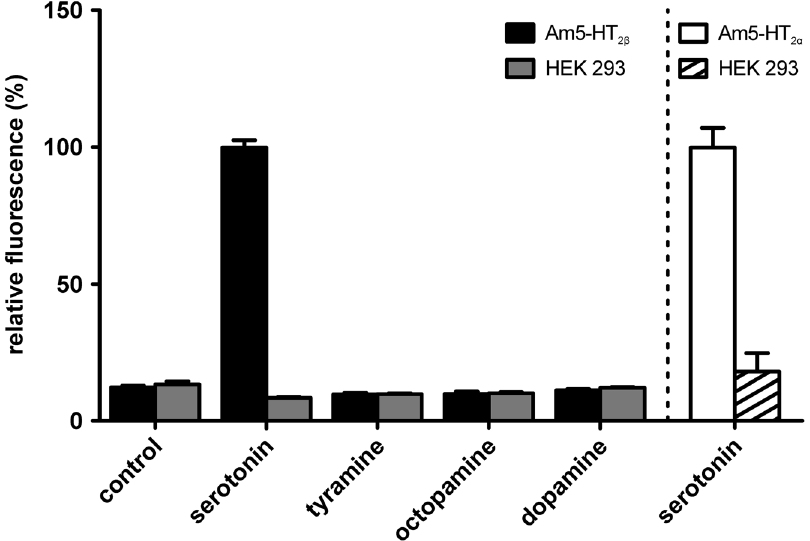
Figure 5. Biogenic amine (10 m M each) modulation of intracellular Ca 2 + concentrations in HEK 293 cells constitutively expressing Am5-HT 2 a or Am5-HT 2ß receptors and in non-transfected HEK 293 cells. Cells were loaded with the Ca 2 + -sensitive dye Fluo-4 and changes in [Ca 2 + ] i were measured fluorimetrically. All values of HEK 293 cells stably expressing Am5-HT 2 b (black bars) and the corresponding non-transfected HEK 293 cells (gray bars) were normalized to the serotonin response of the Am5-HT 2 b -expressing cell line. The values obtained for the Am5-HT 2 a cell line (white bar) and non-transfected HEK 293 cells (striped bar) were normalized analogously. Data represent the mean 6 SD of octuplicate determinations from a representative experiment. The values for serotonin-stimulated Am5-HT 2 a - and Am5-HT 2 b -expressing cells are significantly different from all other values (one-way ANOVA, followed by Dunnett’s multiple comparison test, p , 0.05).